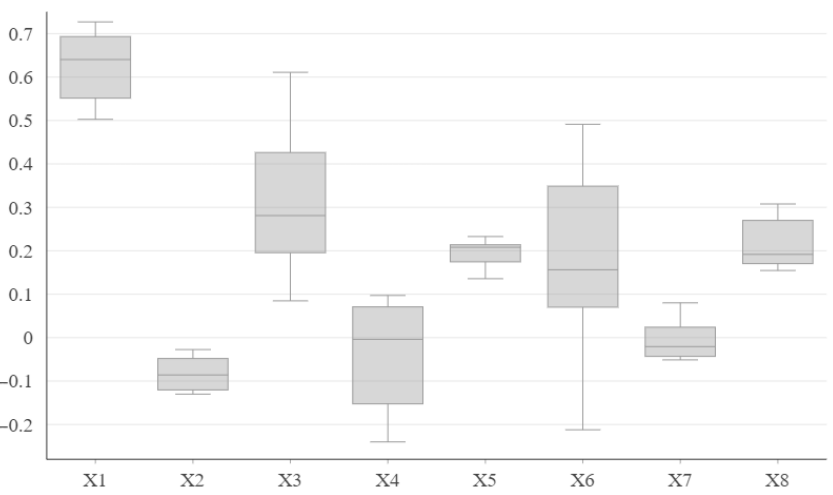
Figure 8. Regression coefficient and significance of spatial distribution of influencing factors of county economic development in Jiangsu Province.